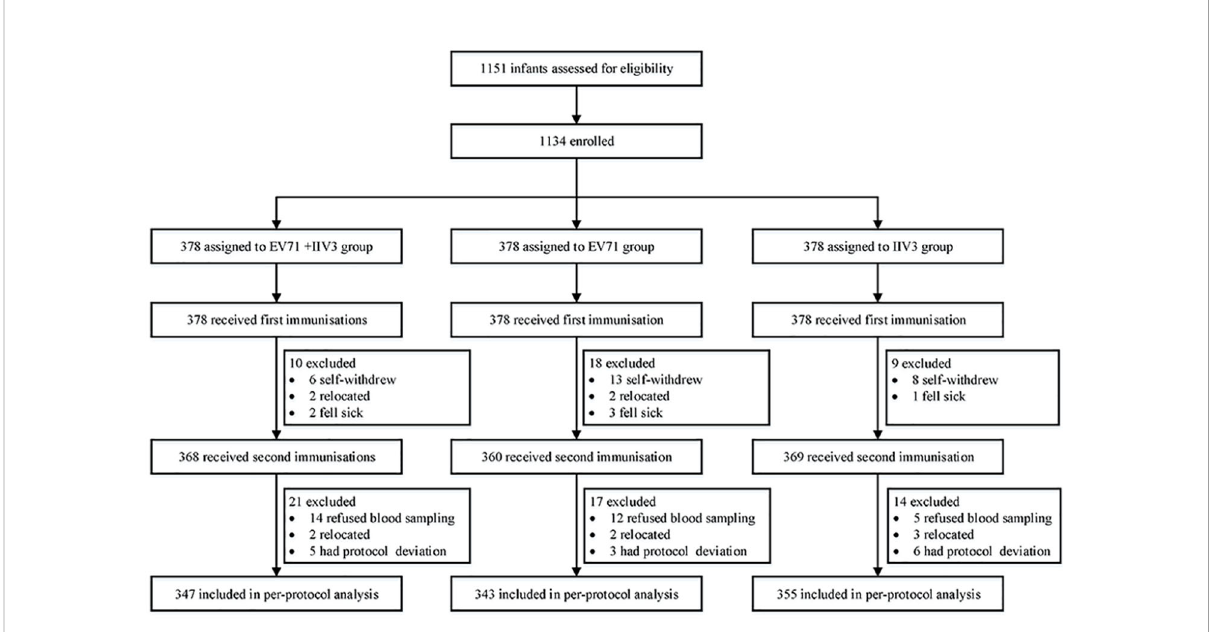
FIGURE 1 Trial pro fi le. EV71= inactivated enterovirus 71 vaccine. IIV3= trivalent split-virion inactivated in fl uenza vaccine.